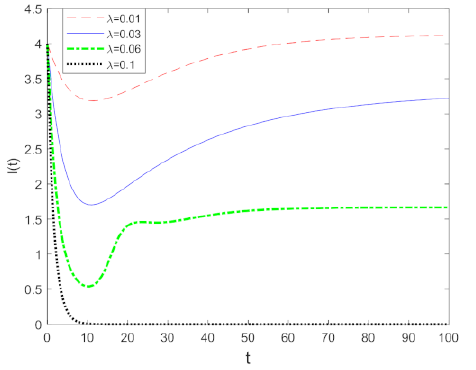
Figure 6. Trends in the number of the rumor spreading with different λ values.